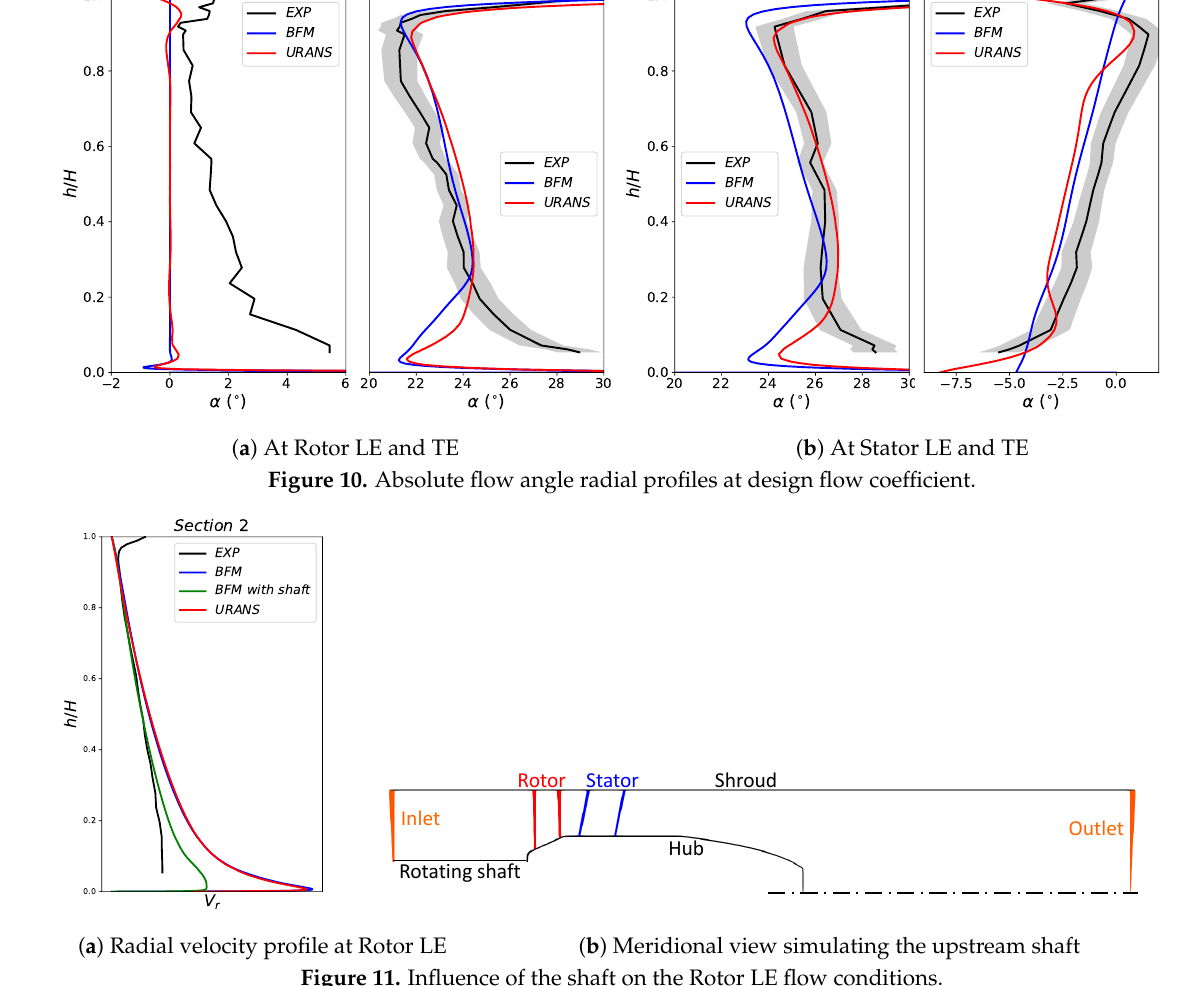
Figure 11. Influence of the shaft on the Rotor LE flow